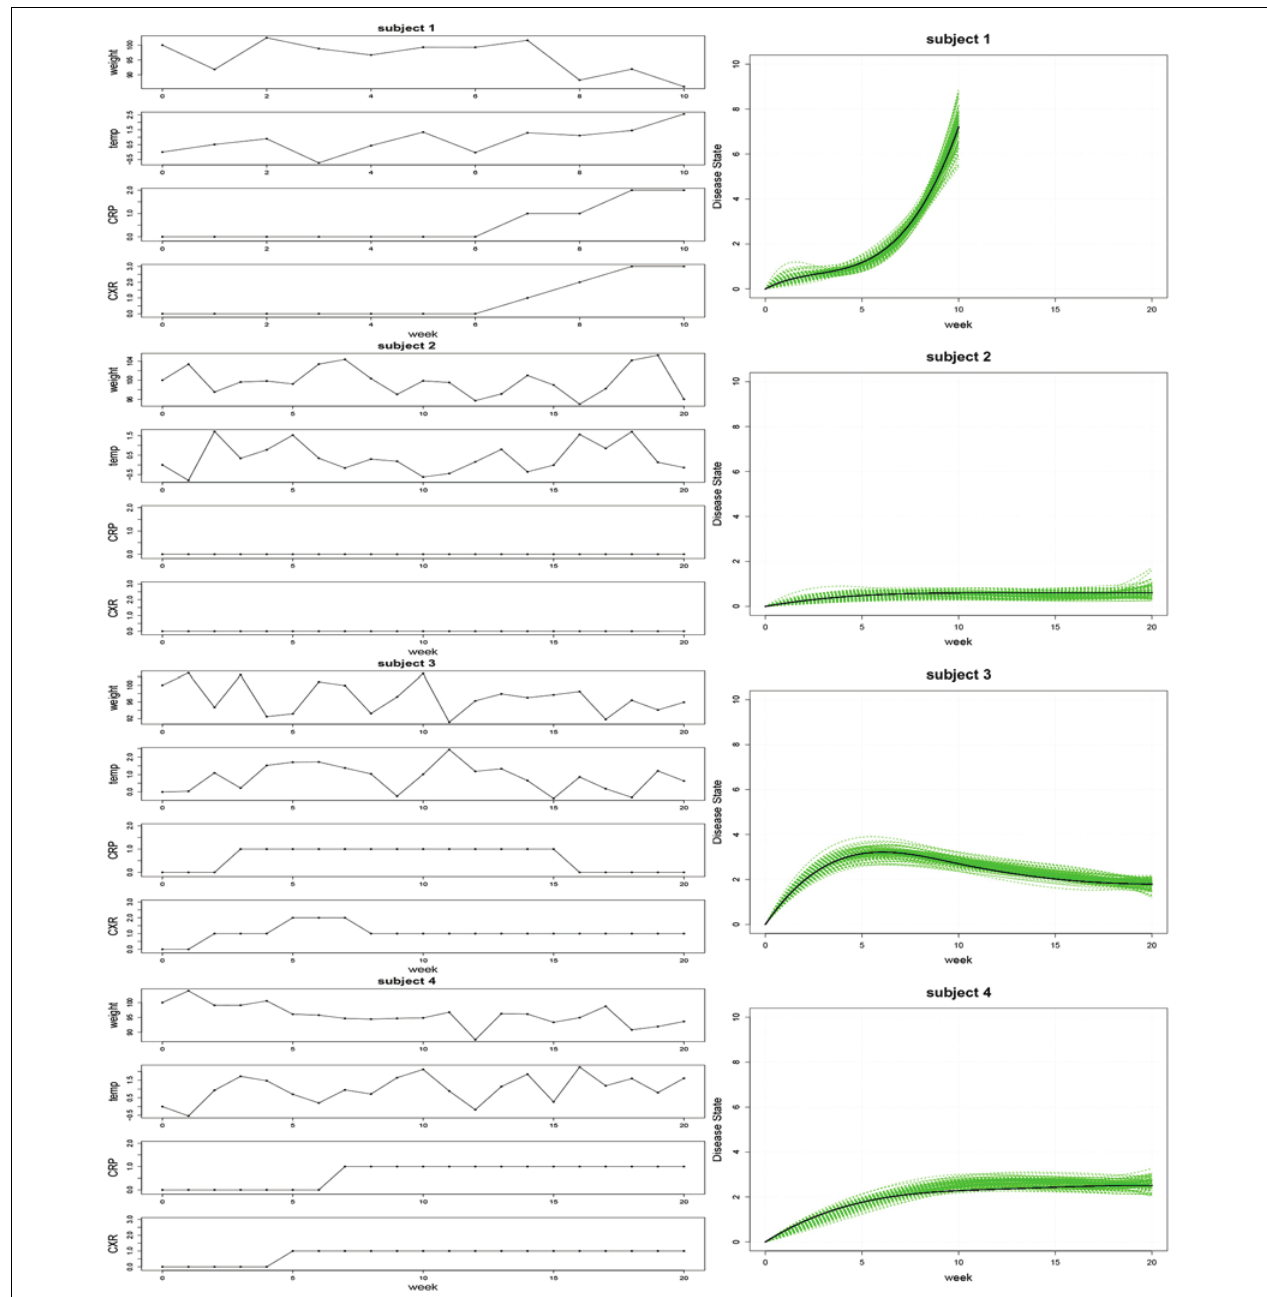
FIGURE 1 | Left: An illustration of the simulated clinical observations for WT, TMP, CRP, and CXR associated with trajectories representing rapid disease progression (subject 1), minimal infection (subject 2), infection followed by